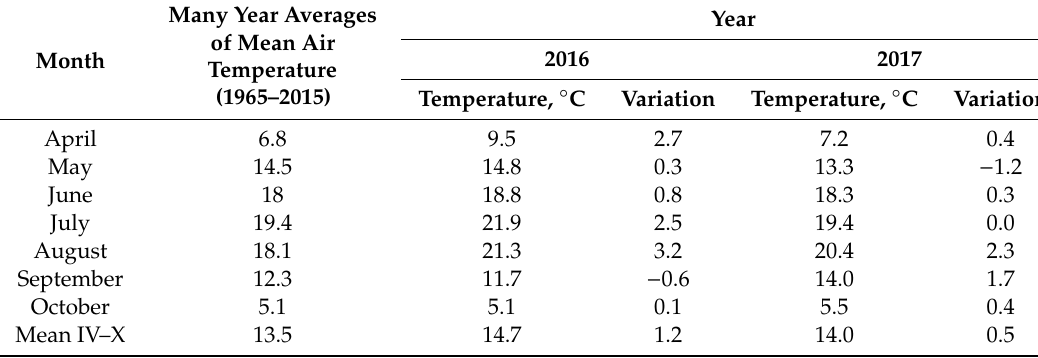
Table 4. Average monthly air temperatures ( ◦ C) during the growing season in 2016 and 2017, according to the Michurinsk Meteorological